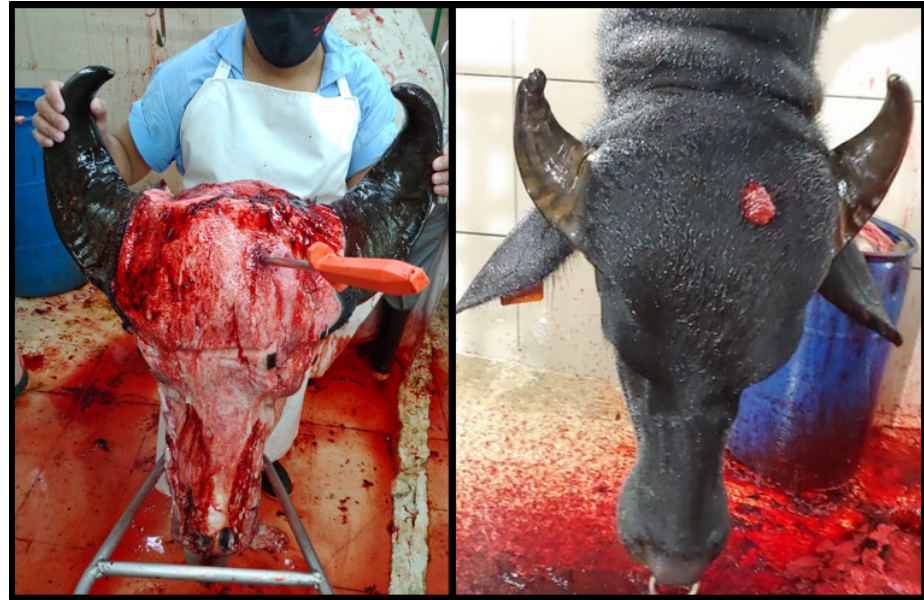
Figure 2. New proposed frontal stunning site (8 cm above the reference point of cattle and approximately 2 cm lateral avoiding midline) showed in three Mediterranean Buffaloes.